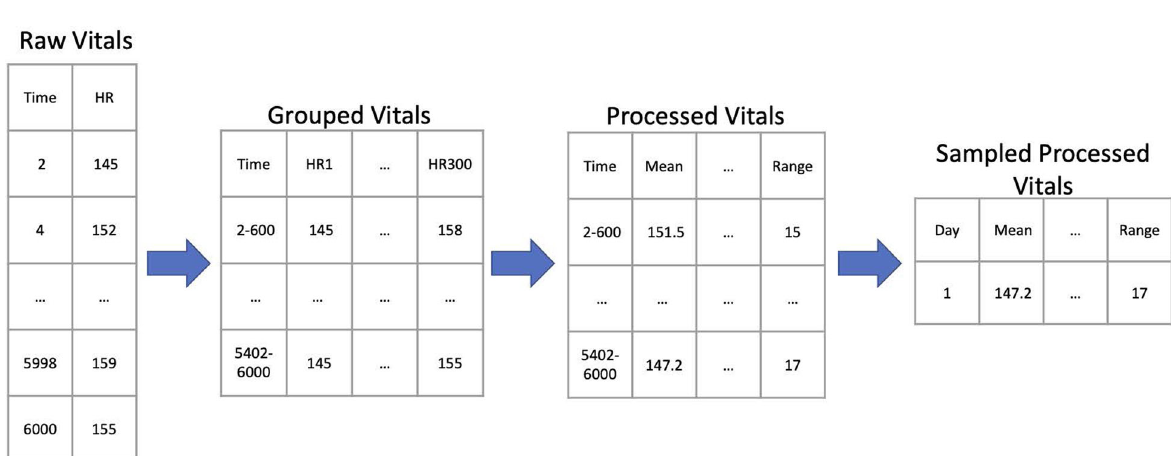
Fig. 6 Data processing work fl ow for heart rate data. From left to right: Each row of the Raw Vitals table contains measured vital signs at 2 s intervals. These values are transposed in the Group Vitals table so that each row has a 600 s time range and up to 300 measured values. Algorithms operate on the Group Vitals table producing the Processed Vitals table of the same size — in the example, the fi rst algorithm is the mean, and the last is the range. The Averaged Processed Vitals table holds the average of each result for a day; the Sampled Processed Vitals table holds the results for a randomly selected 600 s